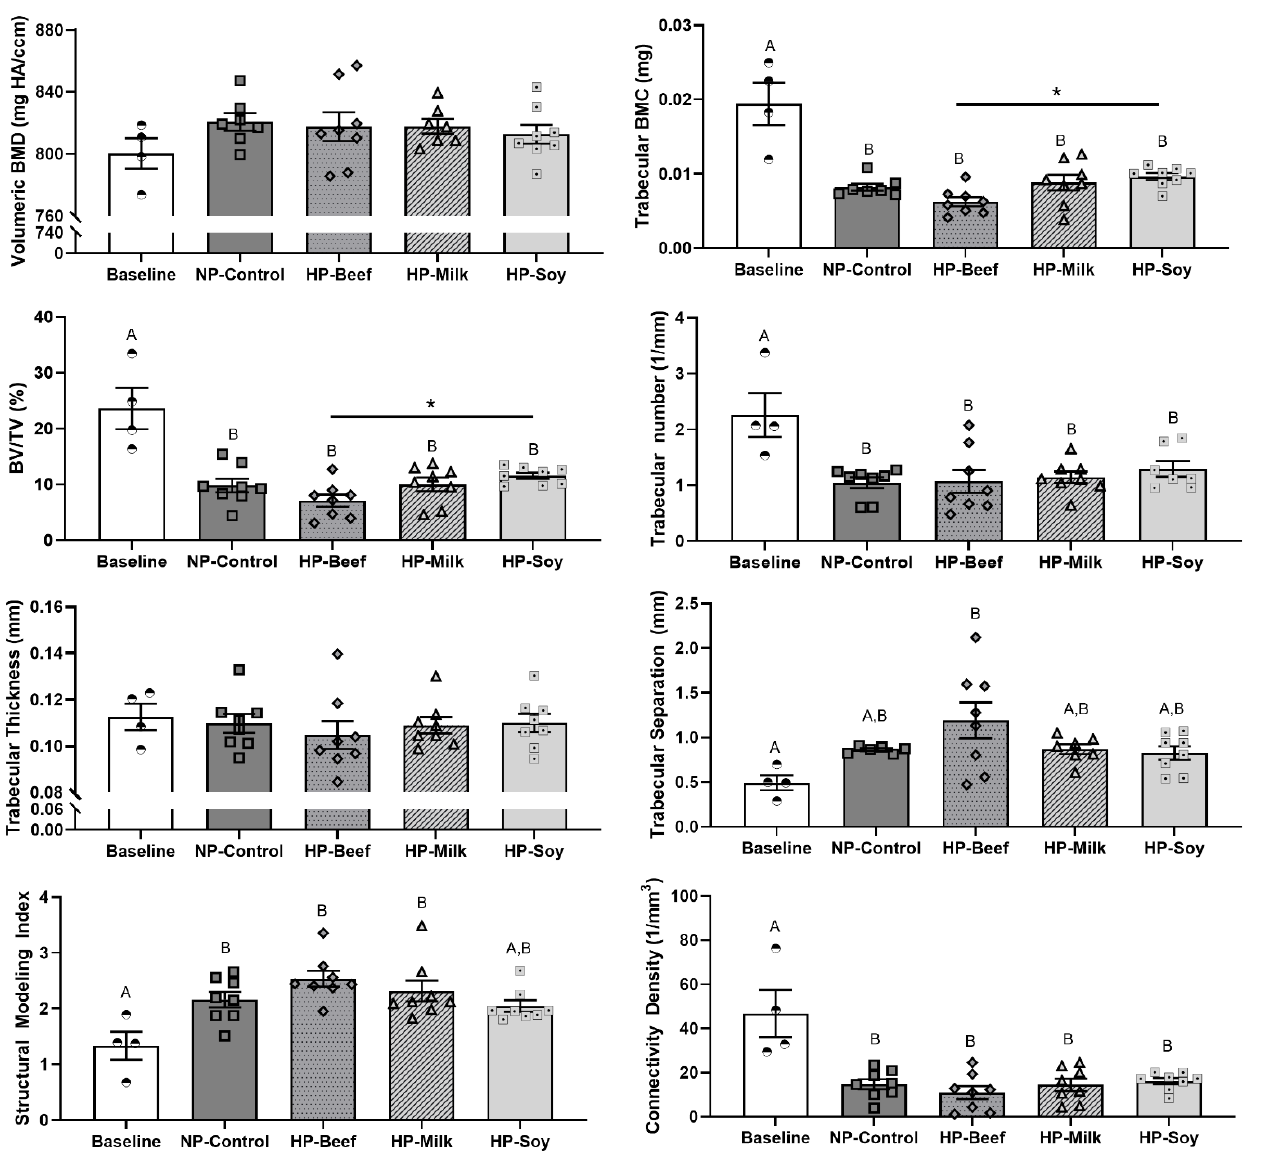
Figure 4. Micro-computed tomography measurements of distal femoral metaphysis: Main effect of weight loss and diet. Weight loss decreased measurements of bone microarchitecture at the distal femoral metaphysis, including trabecular BMC, BV/TV, trabecular number, and connectivity density, while also increasing structural modeling index. Within energy-restricted diets, the HP-soy diet retained more BV/TV and trabecular BMC than the HP-beef diet. Mean ± SEM; BV/TV, trabecular bone volume fraction. Two-way ANOVA were performed; lettering denotes significant main effect of weight loss (A vs. B); * denotes significant main effect of protein source; p < 0.05 considered significant. Relative to baseline, protein source and protein quantity differentially Table 5. Main effect of diet on bone microarchitecture following 12 weeks of energy restriction 1 .